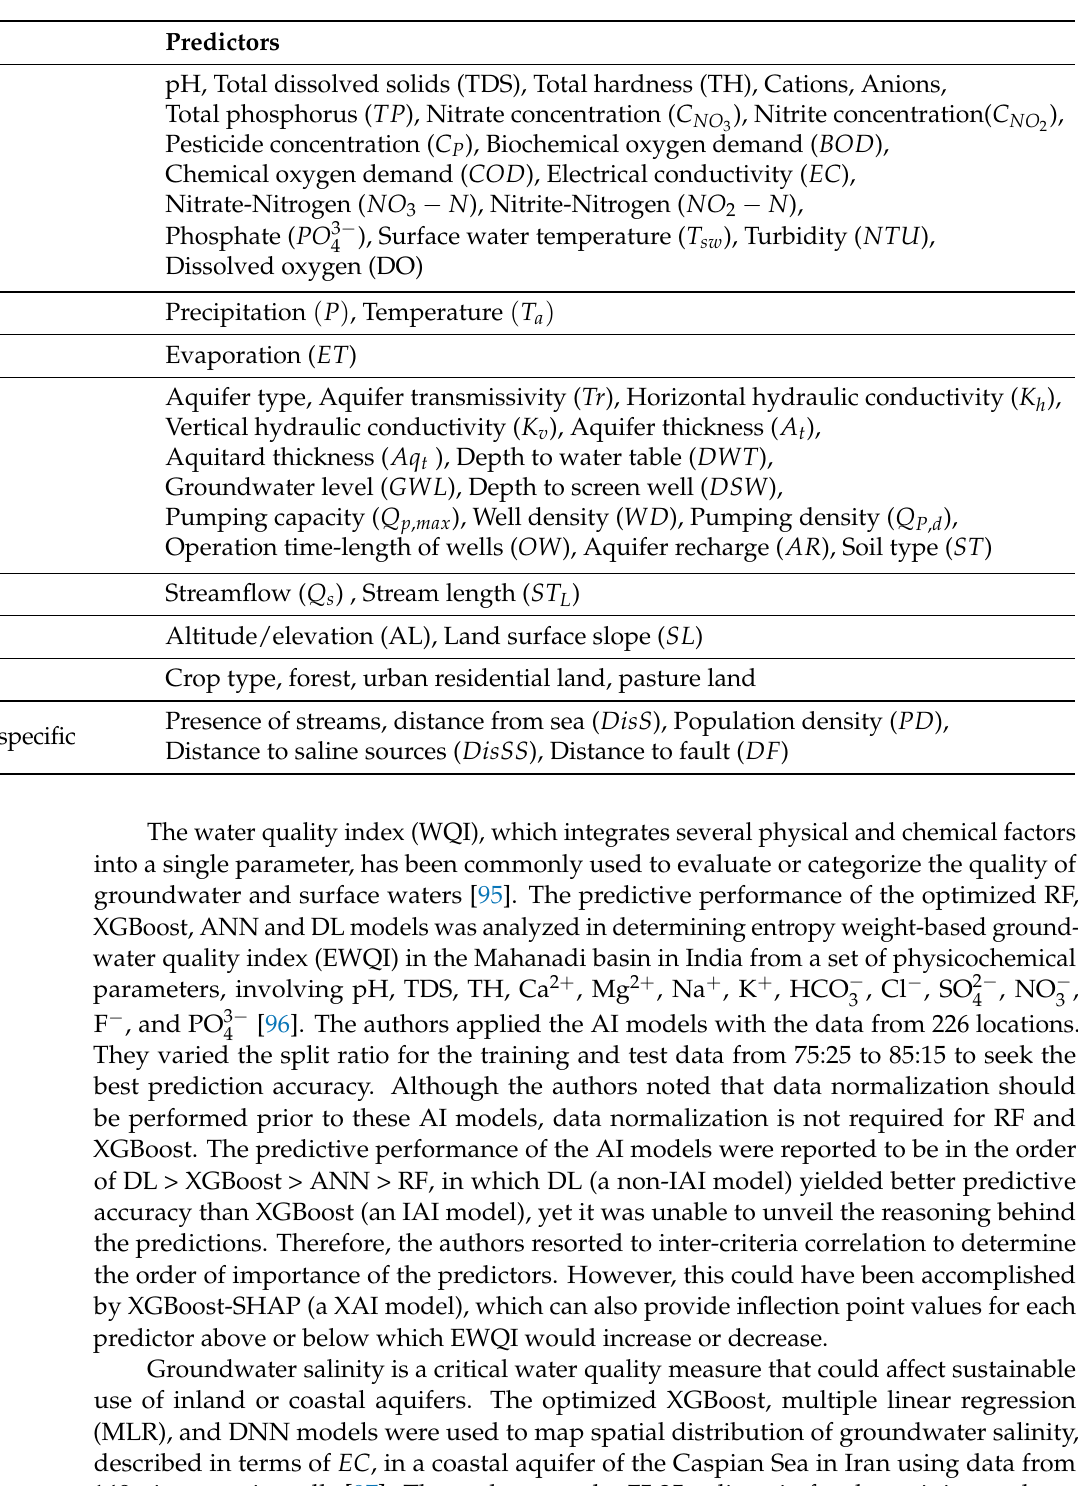
Table 6. Factors and predictors used in IAI-based water quality